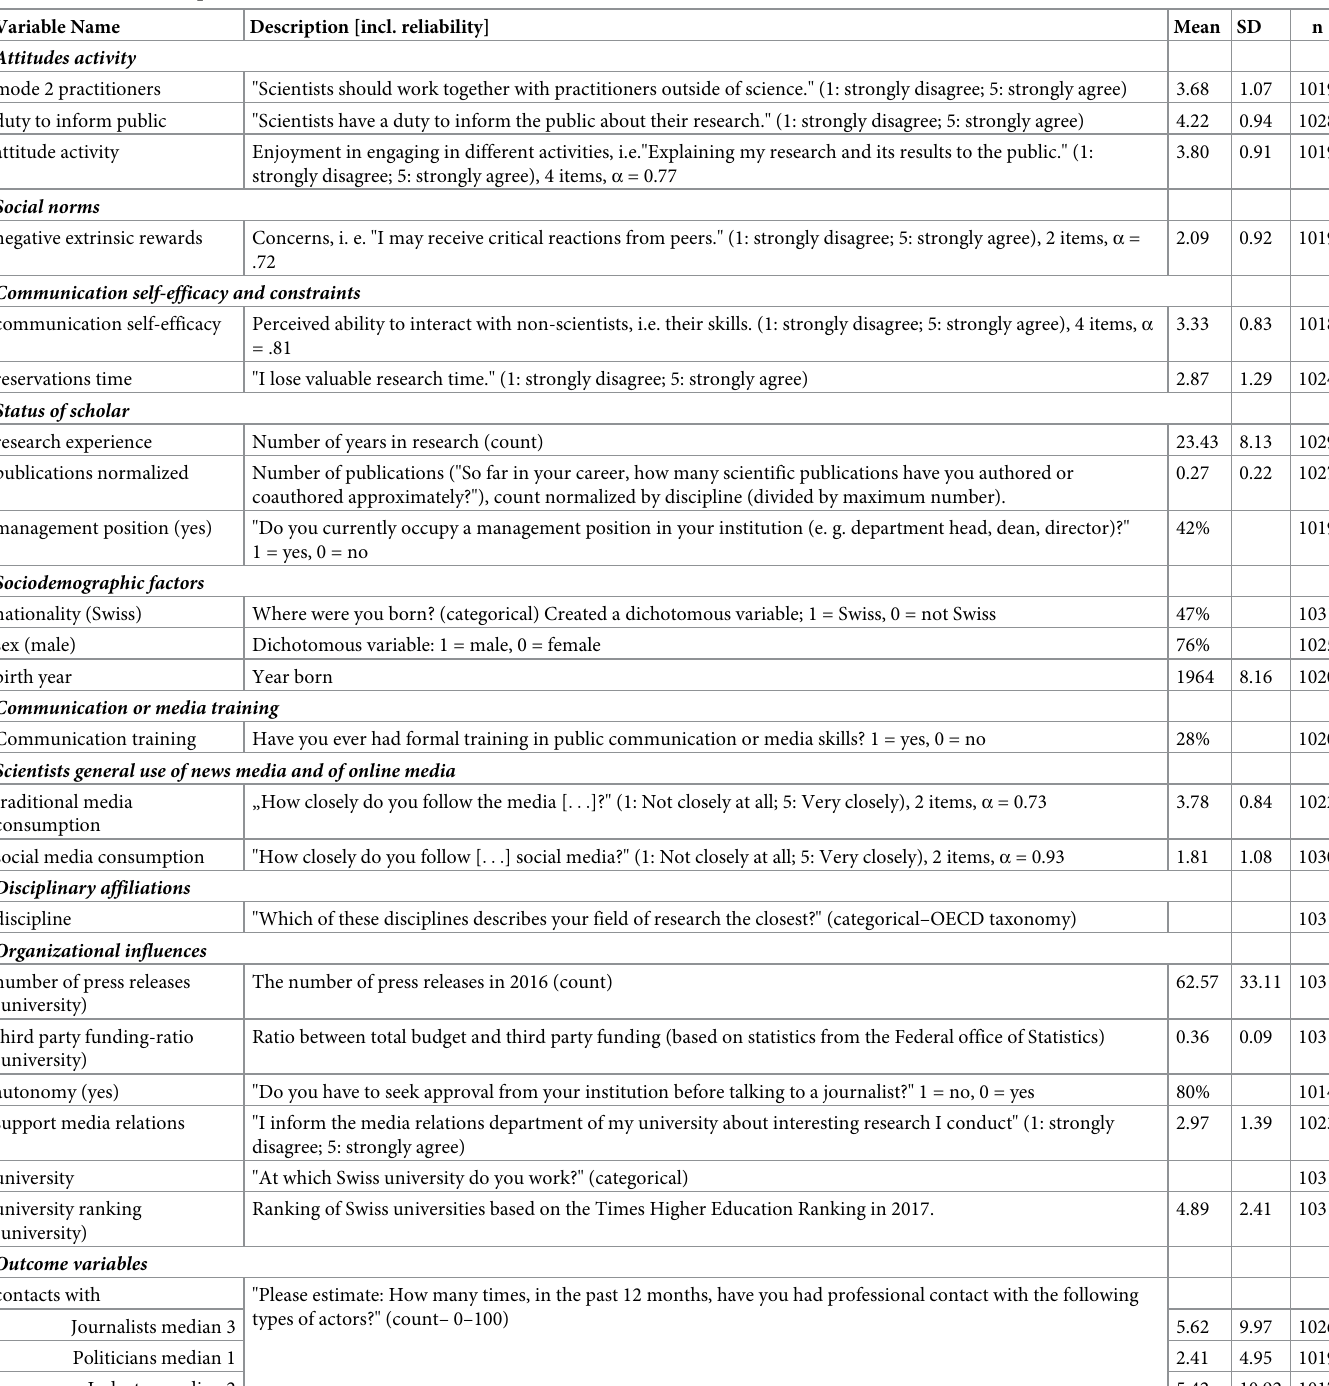
Table 1. Overview of all predictors and outcome